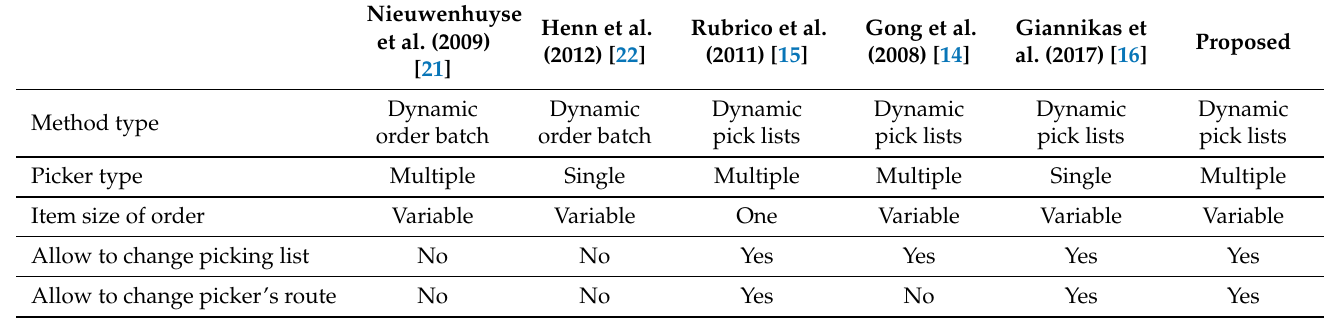
Table 1. Comparison of method type and assumption of the proposed method for previous